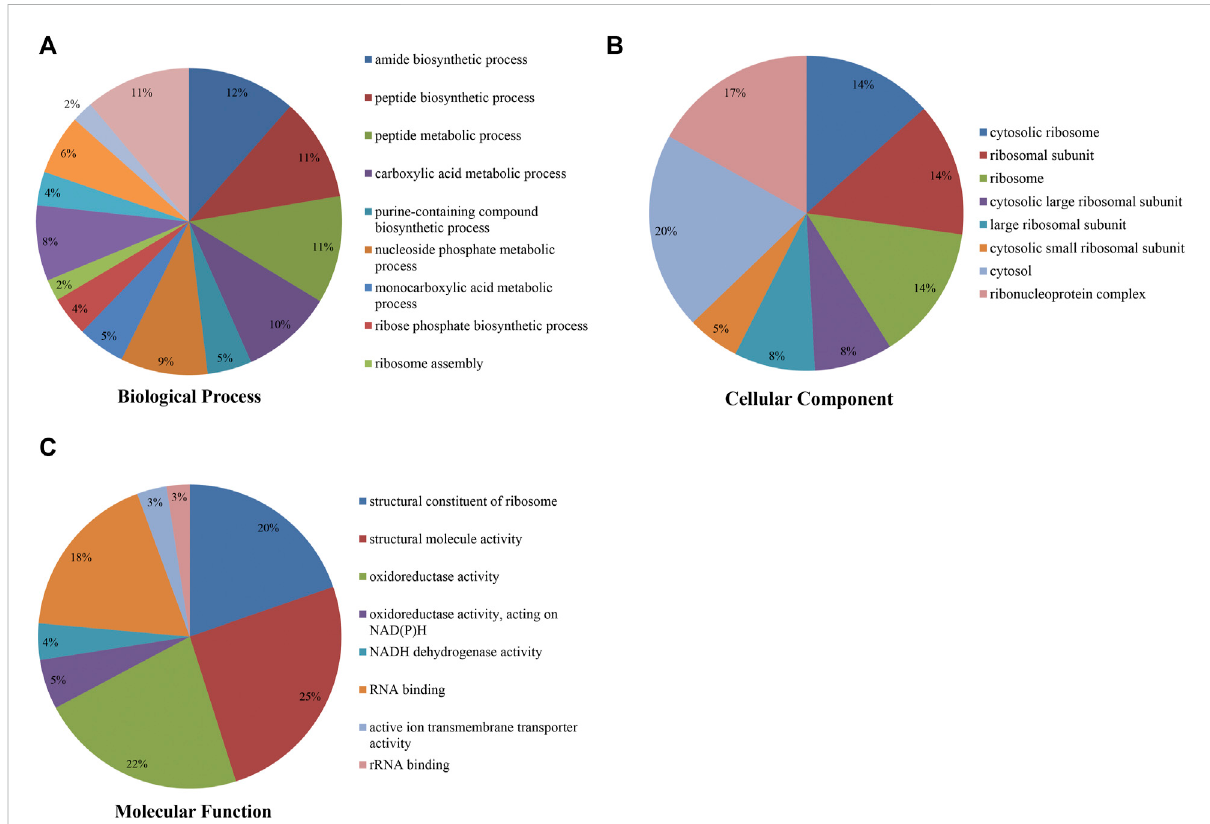
PiechartshowingGeneOntologyanalysisof F.occidentalis proteinswithKlacmodi fi cations. (A) Klacproteins classi fi edaccordingtobiological process. (B) Klac proteins classi fi ed according to cellular component. (C) Klac proteins classi fi ed according to molecular